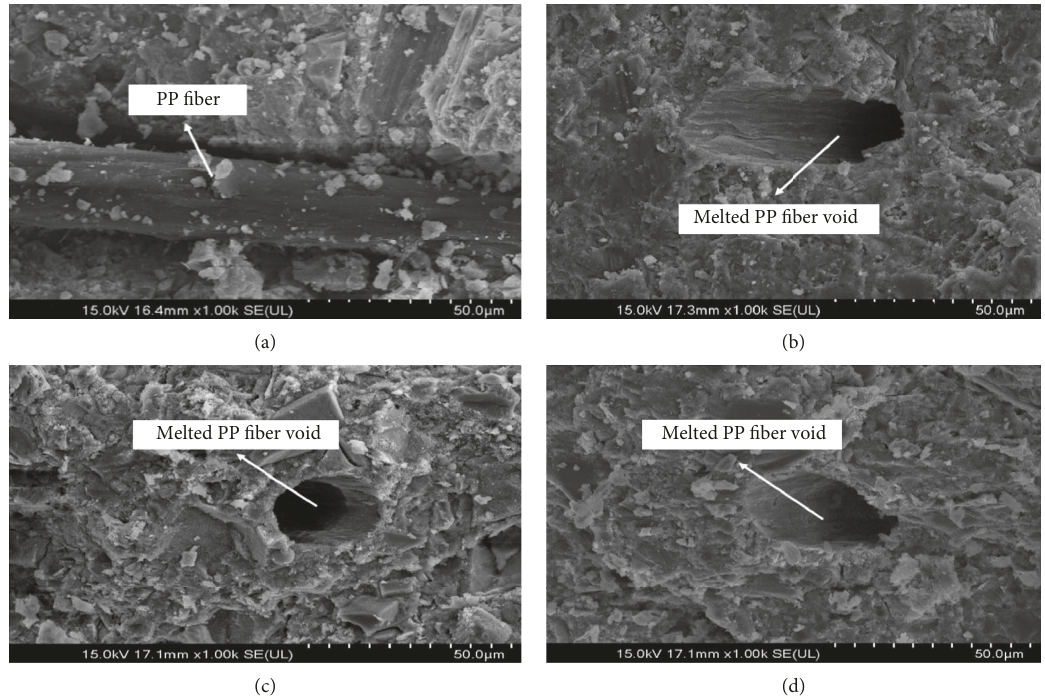
Figure 15: SEM analysis of the UHPC before and after thermal cycling at different temperatures. (a) SEM image before thermal cycling. (b) SEM image at 300 ° C. (c) SEM image at 400 ° C. (d) SEM image at 500 ° C.